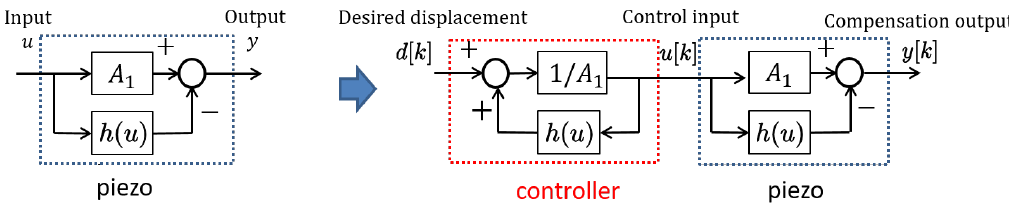
Figure 12. The direct inverse multiplication proposed by Rakotondrabe